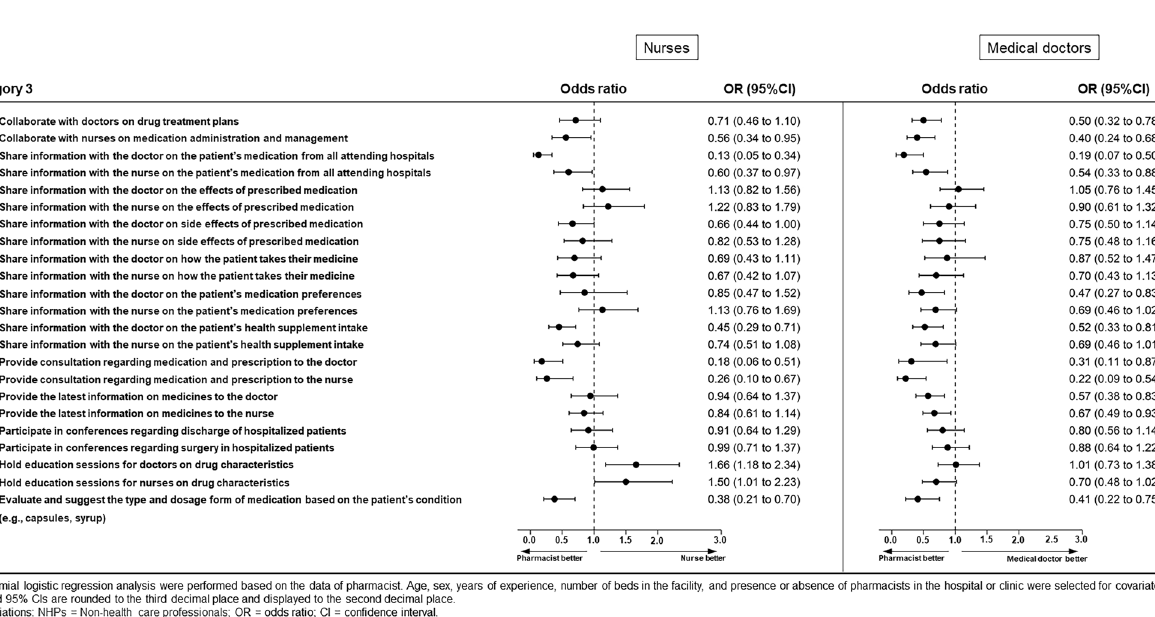
Figure 5. Results of binomial logistic regression analysis for Category 3 for non-health care professionals.